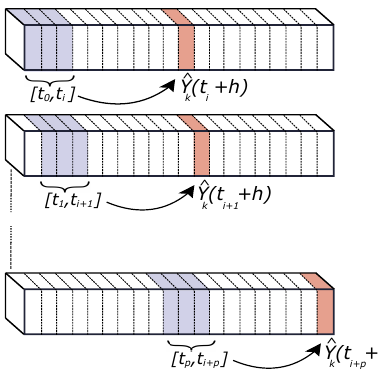
Figure 2. Forecast training strategy for a prediction horizon ( h ).